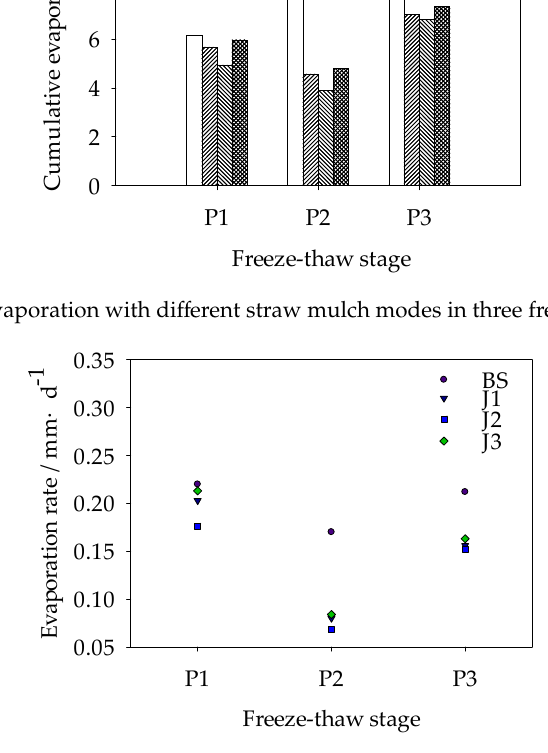
Figure 5. Soil evaporation rate with different straw mulch modes in three freeze–thaw stages.